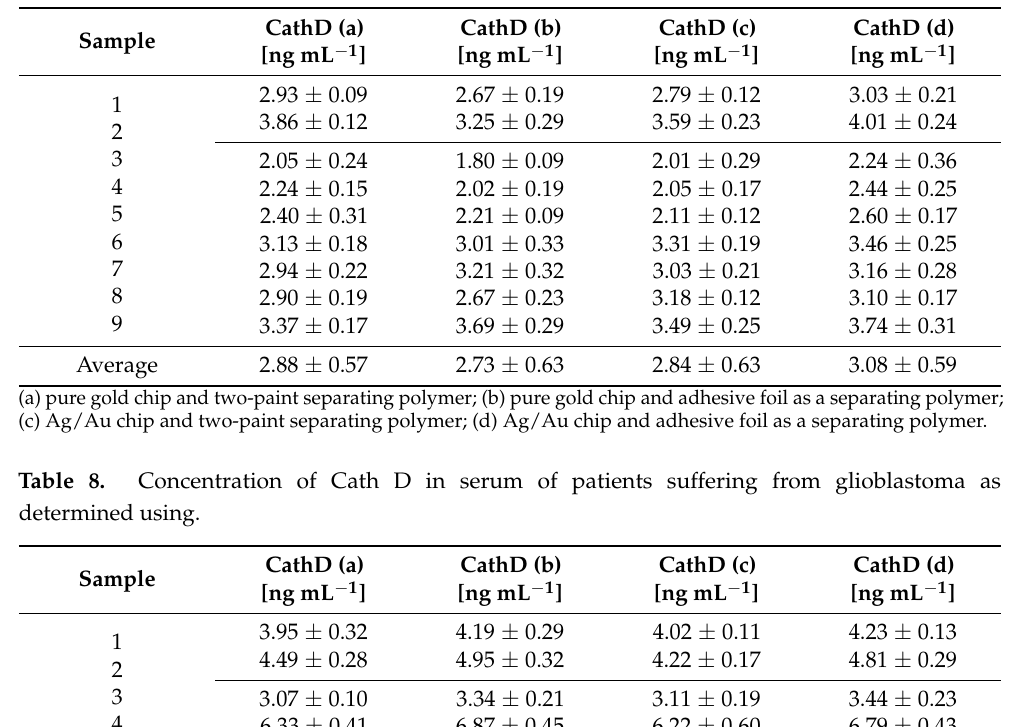
Table 7. Concentration of Cath D in serum of control group, as determined using.